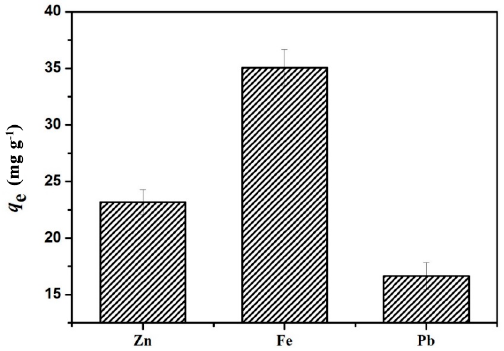
Figure 12. Adsorption amount of various metals on GO(20)/cellulose(100) hydrogels. The error bars represent standard deviations based on three measurements.